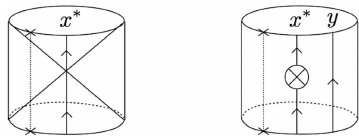
Figure 16 . Every unoriented surface can be decomposed into oriented surfaces and the above two unoriented surfaces. The left diagram represents the orientation-reversing diffeomorphism of a circle, which induces an isomorphism between the vector spaces V represents a cylinder with a cross-cap, which induces a linear map from V